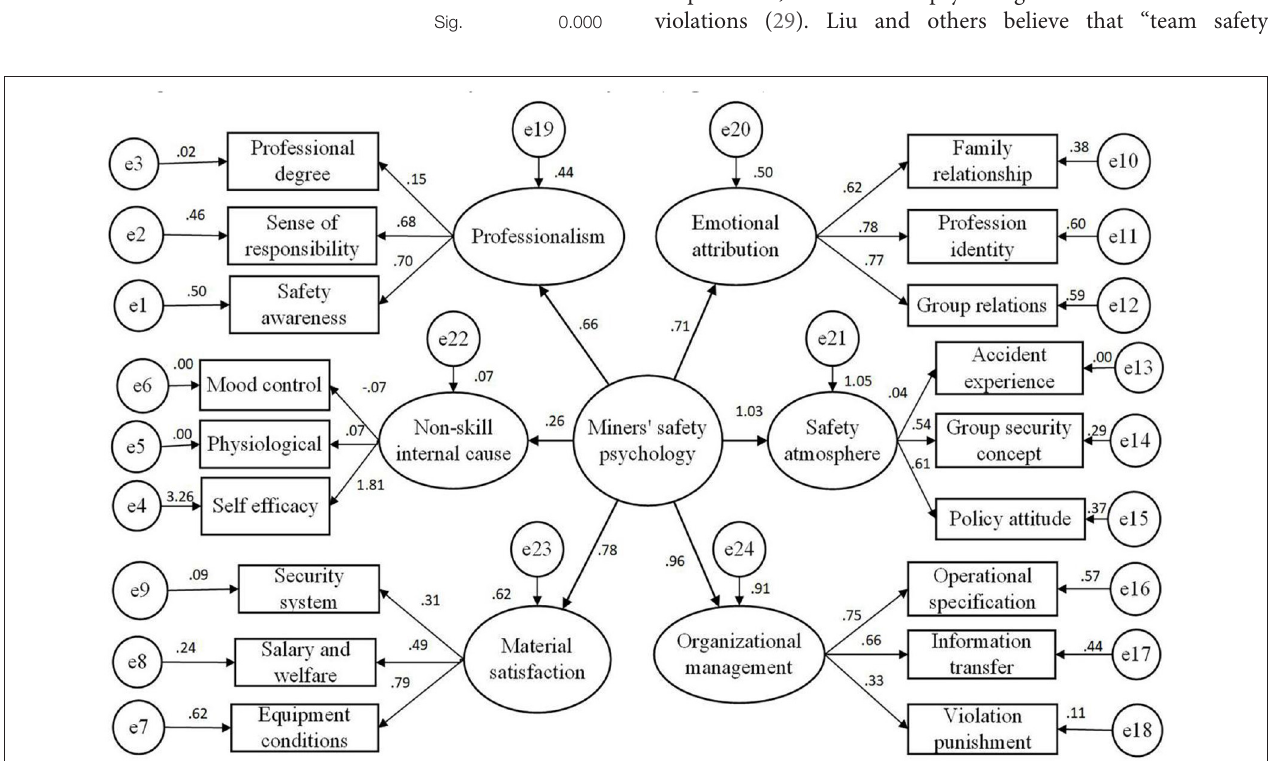
FIGURE 2 | Three layers of safety psychology for